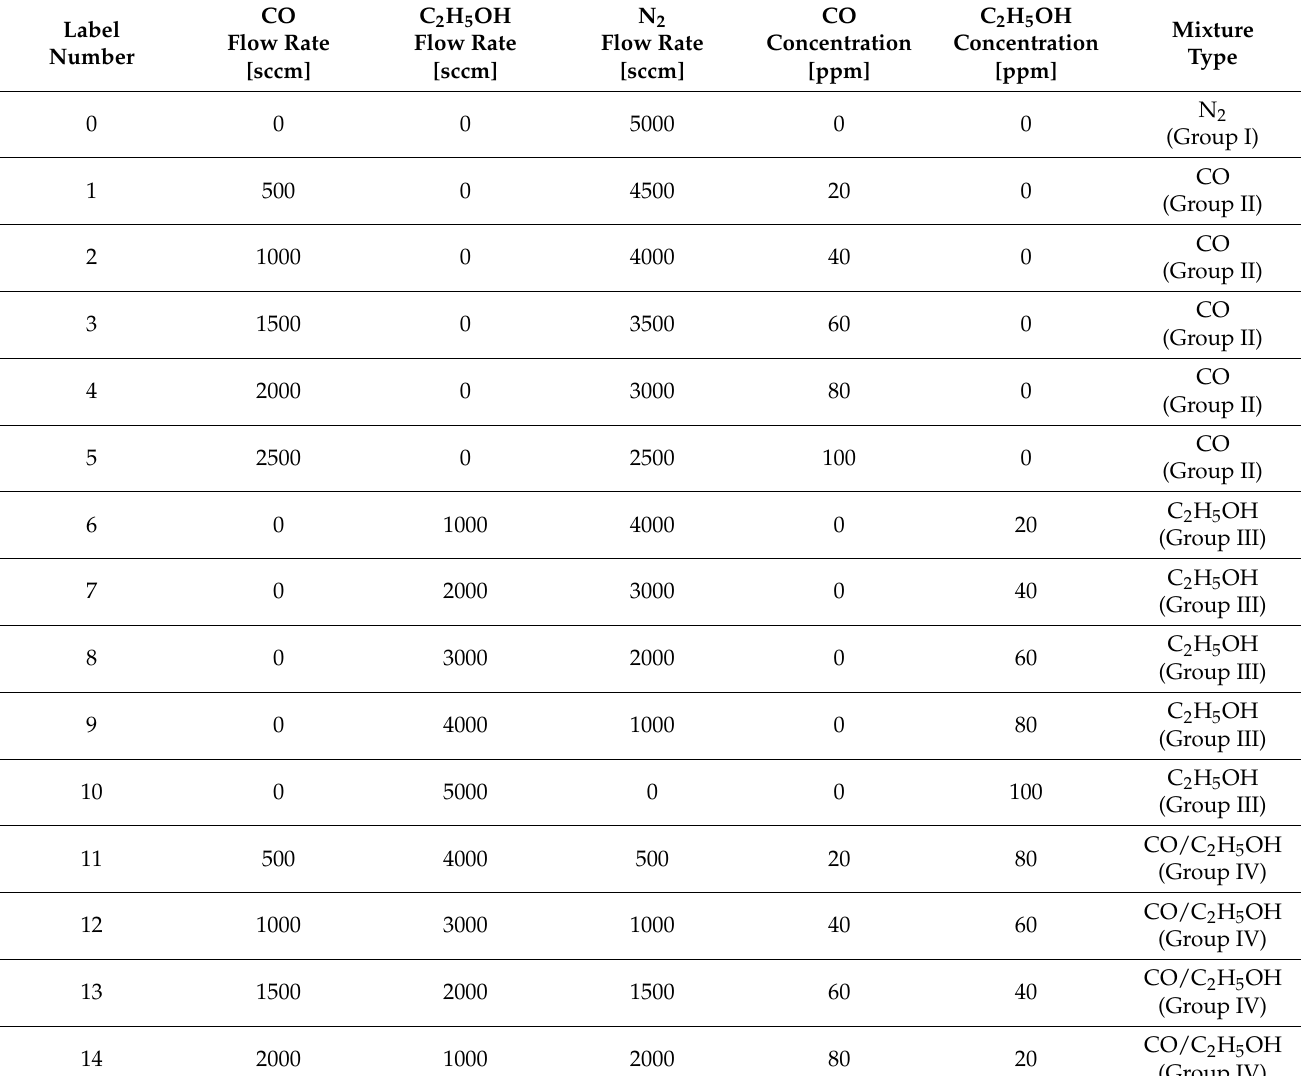
Table 1. Gas combination labels employed to assess the applicability of machine learning to gas sensing classification of CO and C 2 H 5 OH gas mixtures with matrix gas N 2